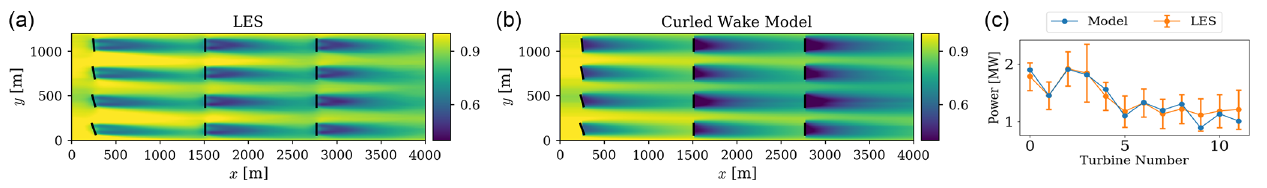
Figure 7. Velocity at hub height normalized by average speed at hub height from the model proposed and from LES and power output for each turbine from the model proposed compared to results from LES. Simulations of a four-by-three turbine array. The bars in the LES power denote 1 standard deviation of the power. Turbine numbering is from bottom to top and left to right.